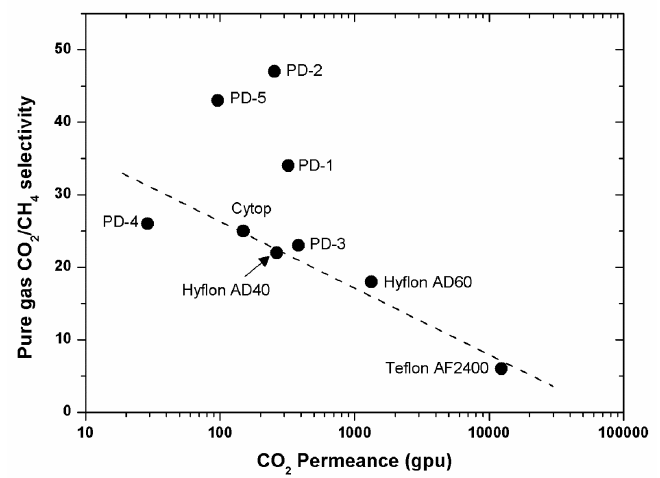
Figure 12. Pure-gas CO 2 / CH 4 selectivity as a function of CO 2 permeance for various perfluorinated polymer membranes. All data were measured at 22 °C, 50 psig feed pressure, and 0 psig permeate pressure. PD-1: PFMDD- co -PFMD 58:42 mol%; PD-2: PFMMD- co -PFMD 60:40 mol%; PD-3: poly(PFMMD); PD-4: poly(PFMD); and PD-5: poly(PFMMD- co -CTFE) 50:50 mol%.